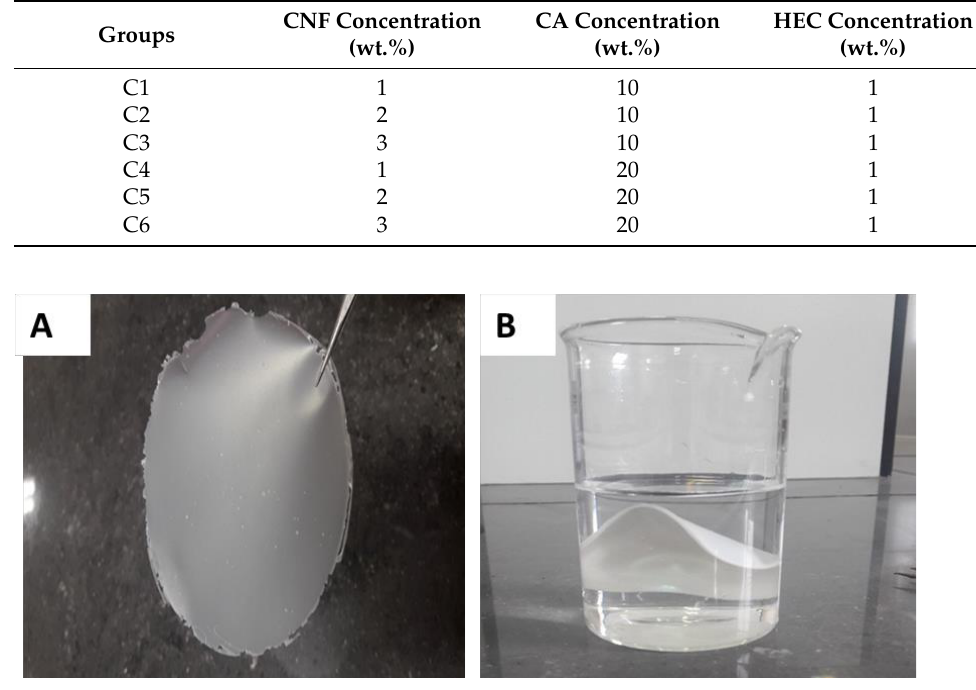
Figure 1. Image of a hydrogel with a ratio of CNF/HEC (3:1 wt.%) and CA 20 wt.% (( A ): in the dry sample and ( B ) in the wet sample).